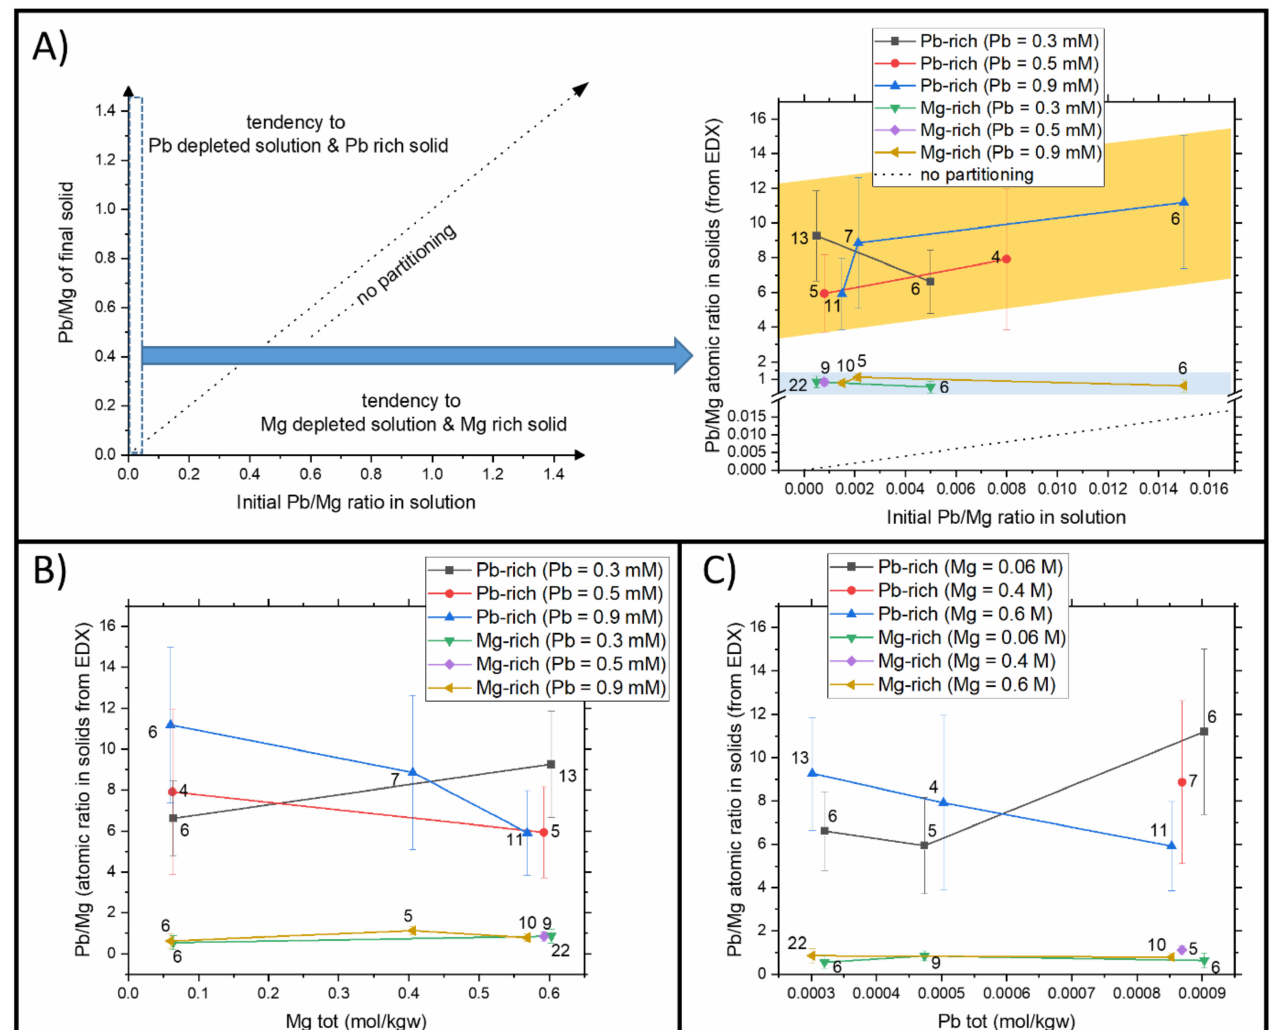
Figure 5. ( A ) Composition of the solid phase as a function of the Pb/Mg ratio in the initial solution. The plot on the left shows the range of compositions investigated and the plot on the right shows the preferential incorporation of Pb in the solid phases. ( B ) Composition of the solid phases as a function of the initial total magnesium content. ( C ) Composition of the solid phases as a function of total lead content. The numbers next to the symbols refer to the number of independent EDX analyses used to calculate the averages and the standard